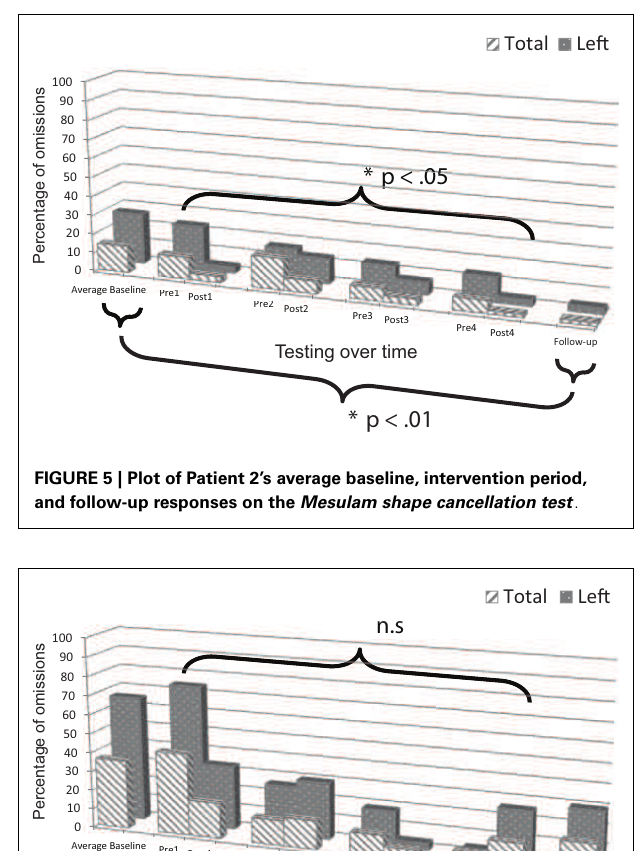
FIGURE 6 | Plot of Patient 1’s average baseline, intervention period, and follow-up responses on the BIT star cancellation test .